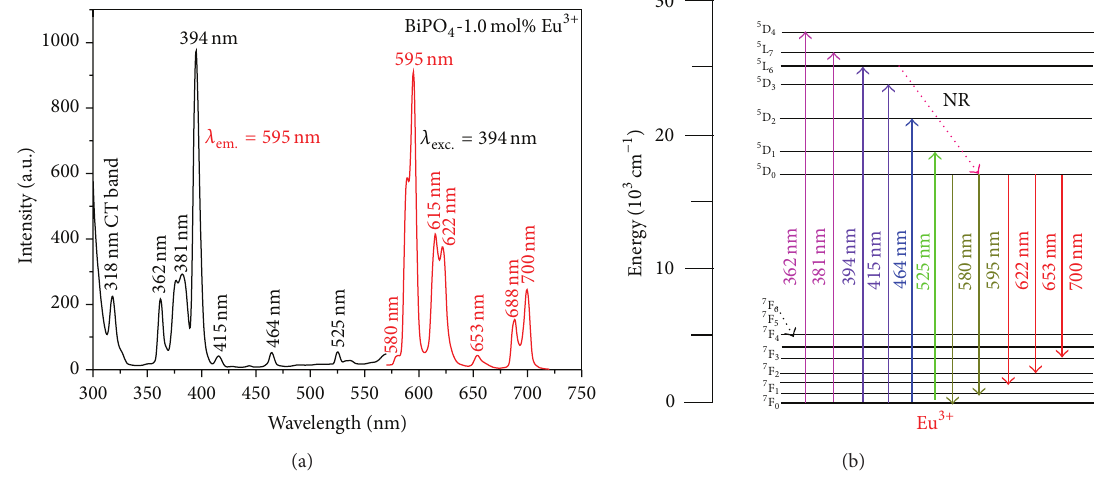
Figure 6: (a) PLE and PL spectra of 1.0mol% singly Eu 3+ doped sample and (b) corresponding energy level